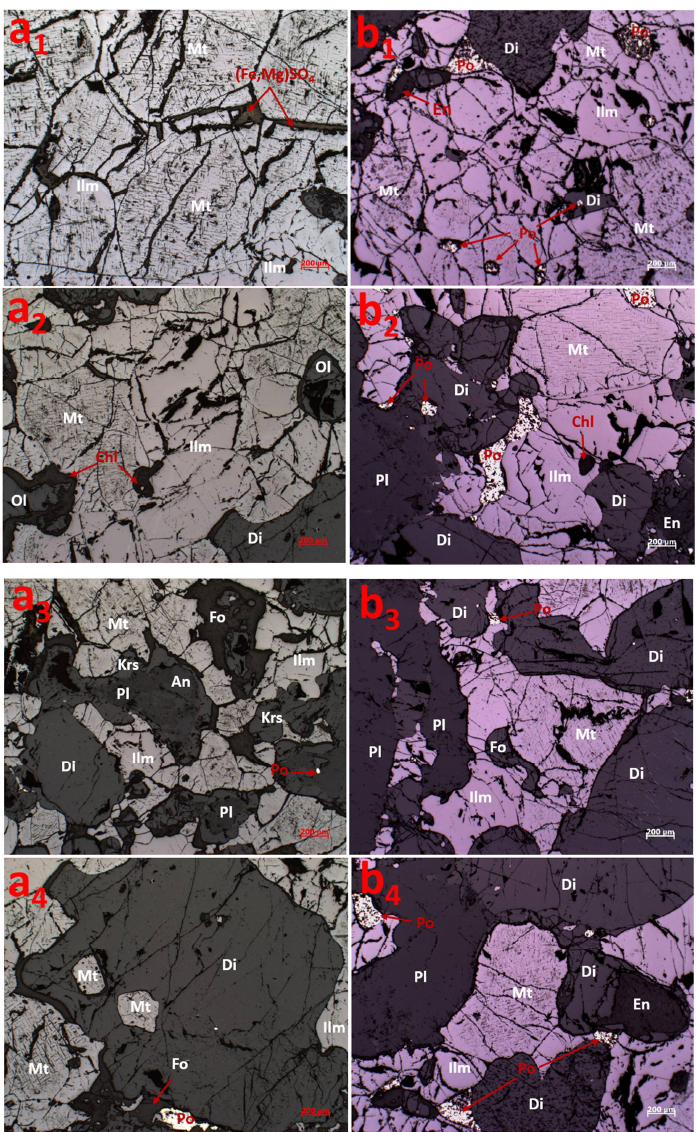
Figure 4. Reflected light micrographs of ( a 1 – a 4 ) A-1 and ( b 1 – b 4 ) A-2 ores (Ilm = ilmenite, Mt = titanomagnetite, Di = diopside, En = enstatite, Po = pyrrhotite, Pl = plagioclase, An = anorthosite, Ol = olivine, Chl = chlorite, Fo = forsterite, Krs = kaersutite). (1) In type A-1, the ilmenite and titanomagnetite (Fe-Ti oxide) aggregates exhibited mainly euhedral/semi-euhedral and semi-euhedral/other crystalline structures, corre- sponding to gangue minerals being scattered in the gaps between the Fe-Ti oxide aggre- gates (Figure 4(a 1 ),(a 2 )). In addition, local Fe-Ti oxide aggregates were also present and exhibited spongy meteorite-like and other granular structures (Figures 4(a 3 ),(a 4 ) and 5(a 1 )– (a 3 )).